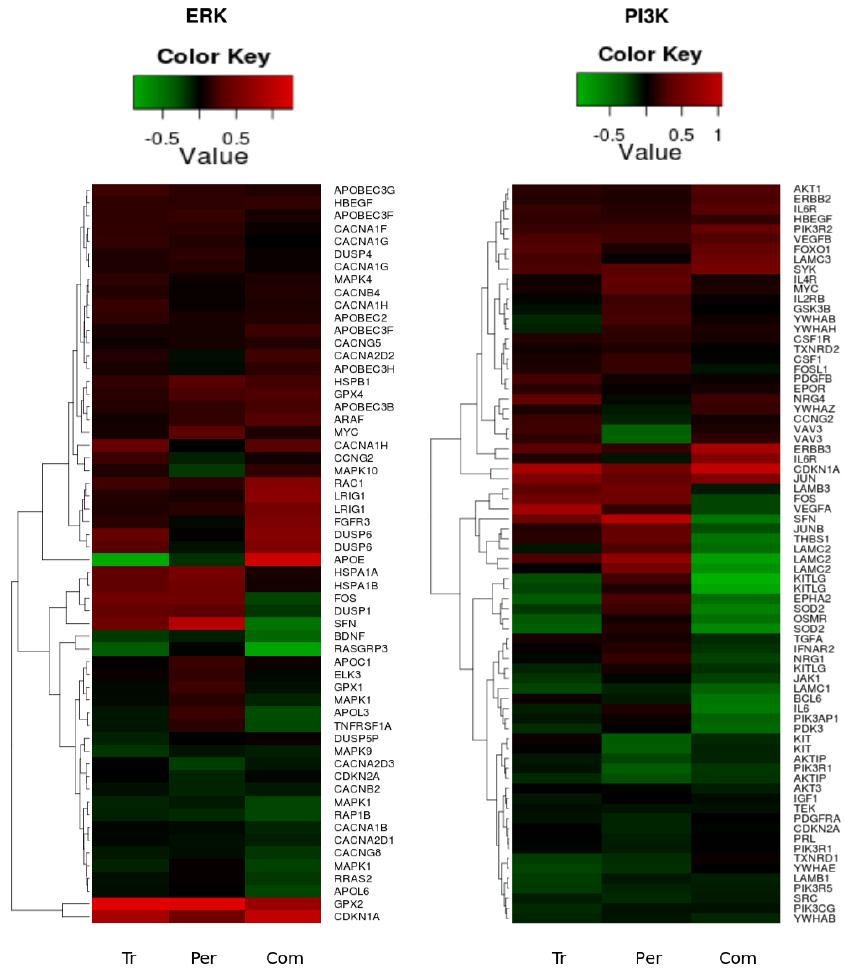
Figure 8. Heatmaps of the significant ( p -value < 0.05) gene expression fold change in the PI3K/AKT (left heatmap) and ERK1/2 (right heatmap) pathways following trastuzumab (Tr), pertuzumab (Per), and their combination (Com) treatments of SKOV3 ovarian xenograft tumour